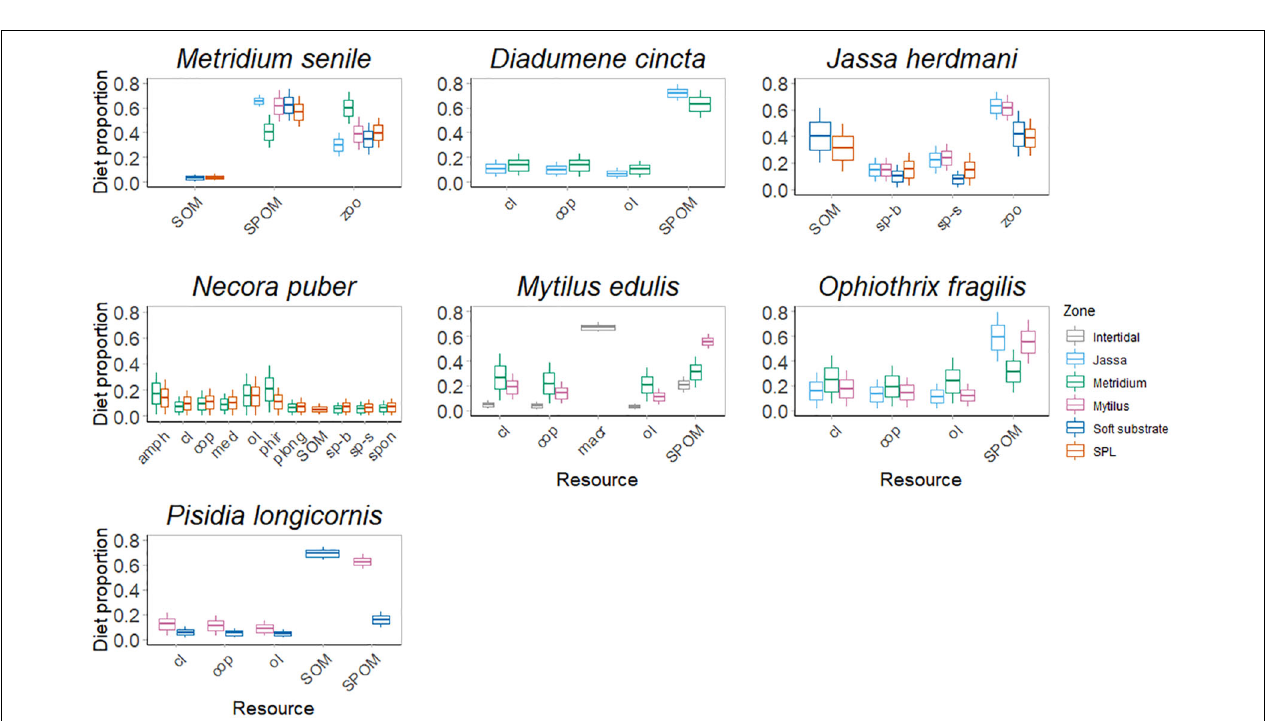
FIGURE 7 | Potential contribution of each resource to the diet of each species in the different zones. The different colors represent the different zones. The colored boxplots represent the 25 th percentile, the median and the 75 th percentile of the dietary proportions, while the whiskers represent the 1.5 × interquartile ranges (IQR) of the upper and lower quartile. Abbreviations refer to the different resources: cop, copepods; cl, crab larvae; ol, other larvae; zoo, zooplankton; sp-b, SPOM-bottom; sp-s, SPOM-surface; SPOM, suspended particulate organic matter; SOM, sediment organic matter; macr, macroalgae; amph, Amphipoda; med, Mytilus edulis ; phir, Pilumnus hirtellus ; plong, Pisidia longicornis ; spon, Spongidae.